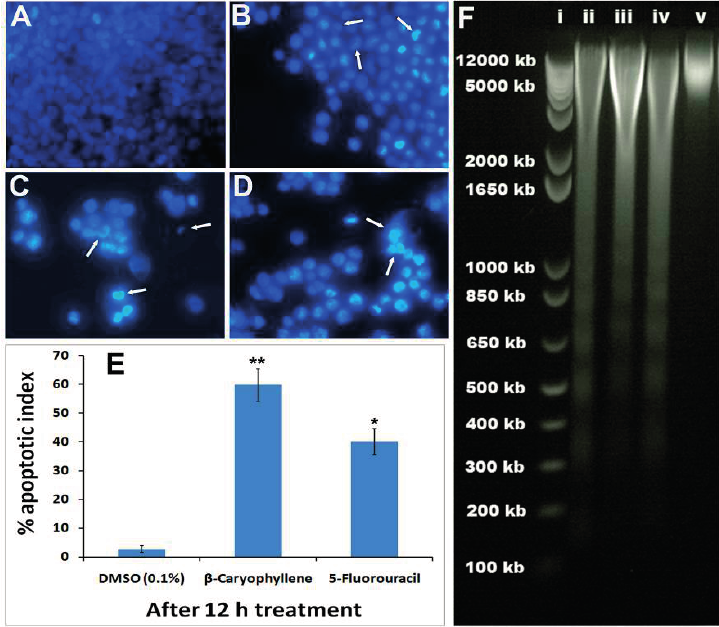
Figure 6. Photomicrographs depicting images of HCT 116 cells with Hoechst 33258 staining ( A ) Cells treated with vehicle (0.1% DMSO). The vehicle-treated cells revealed an intact cell membrane with an evenly distributed nucleus in cytosol; ( B ) Cells after 6 h of β -caryophyllene (10 µM) treatment. Cells treated with β -caryophyllene displayed early stage apoptotic symptoms such as membrane blebbing and chromatin condensation (arrows); ( C ) Cells after 12 h of β -caryophyllene (10 µM) treatment. The arrows indicate the advanced staged apoptotic signs such as of nuclear dissolution including the half-moon (crescent) shaped apoptotic nuclei. In addition, at several places, the arrows mark chromatin breakdown and fragmentation; ( D ) Cells treated with standard reference, 5-flourouracil (10 µM)